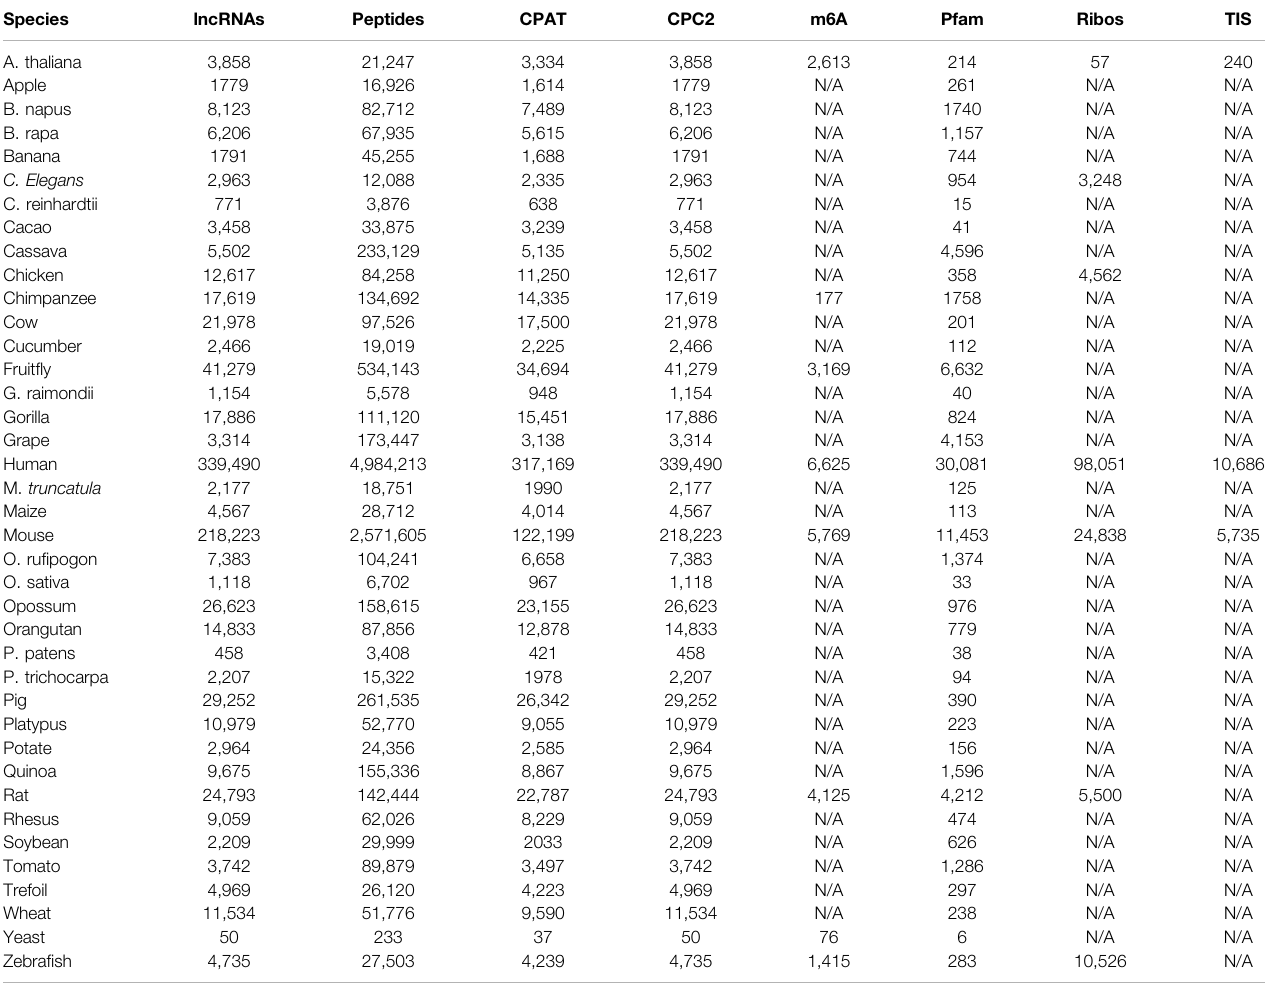
TABLE 1 | Summary of lncRNAs, peptides, and evidences across 39 species.